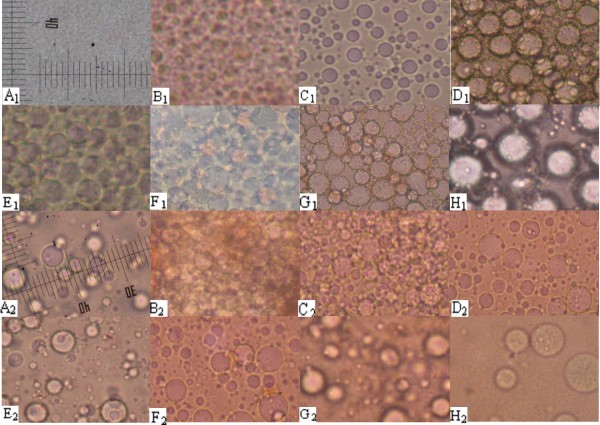
Morphological changes of ME-RCA and MBG-RCA in the gastrointestinal tract of normal rats observed by microscopy. A1 - Prepared ME-RCA; B1 - ME-RCA in stomach 10 min; C1 - ME-RCA in stomach 20 min; D1 - ME-RCA in stomach 30 min; E1 - ME-RCA in stomach 60 min; F1 - ME-RCA in stomach 120 min; G1 - ME-RCA in small intestine; H1 - ME-RCA in colon (× 400) A2 - Prepared MBG-RCA; B2 - MBG-RCA in stomach 10 min; C2 - MBG-RCA in stomach 20 min; D2 - MBG-RCA in stomach 30 min; E2 - MBG-RCA in stomach 60 min; F2 - MBG-RCA in stomach 120 min; G2 - MBG-RCA in small intestine; H2 - MBG-RCA in colon (× 400)